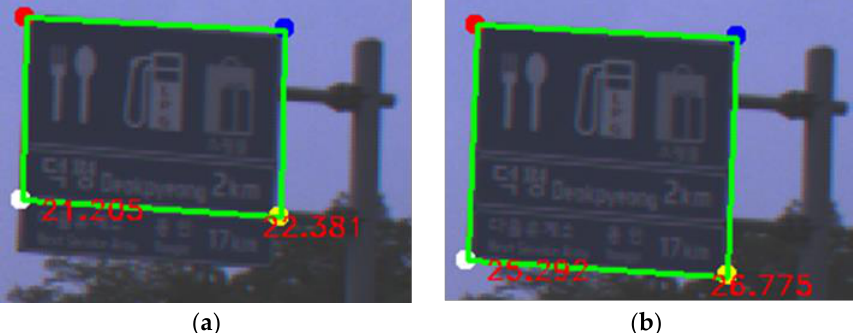
Figure 10. The effect of NMS considering the height of the road sign (( a ): considering only the road sign HV score, ( b ): considering the height as